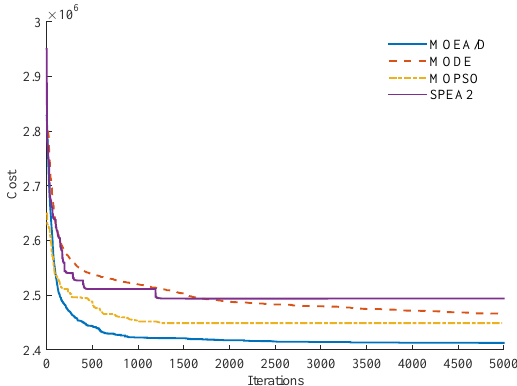
Figure 7. Convergence property of emission objective function.